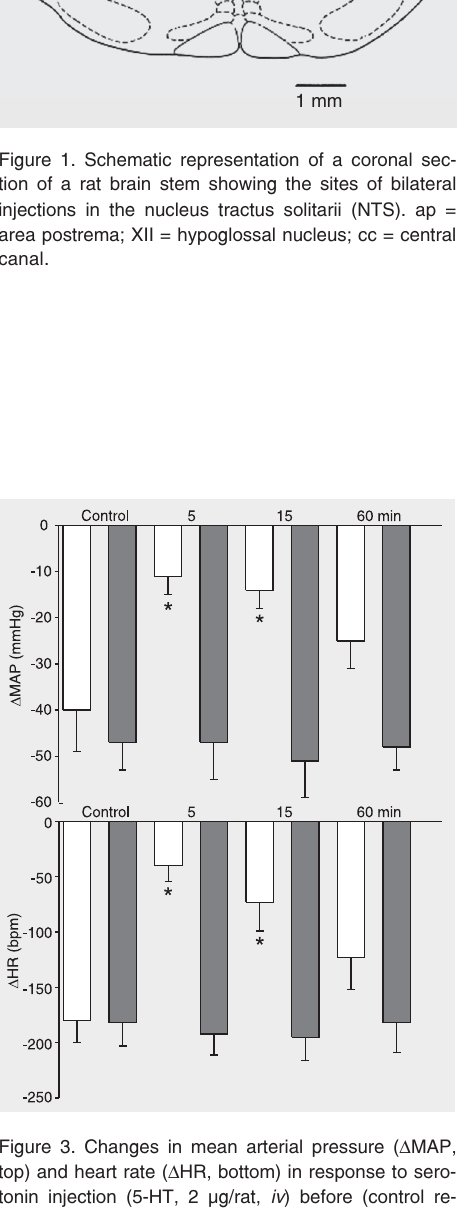
test).Figure 2. Mean arterial pressure (MAP, top) and heart rate (HR, bottom) before (control, C) and 5, 15, and 60 min after bilateral injections of vehicle (0.9% sa- line, N = 5; squares), muscimol (50 pmol/50 nl, N = 8; lozenges) or baclofen (12.5 pmol/50 nl, N = 7; circles) into the NTS. *P < 0.05 compared to the respective control (ANOVA followed by the Tukey